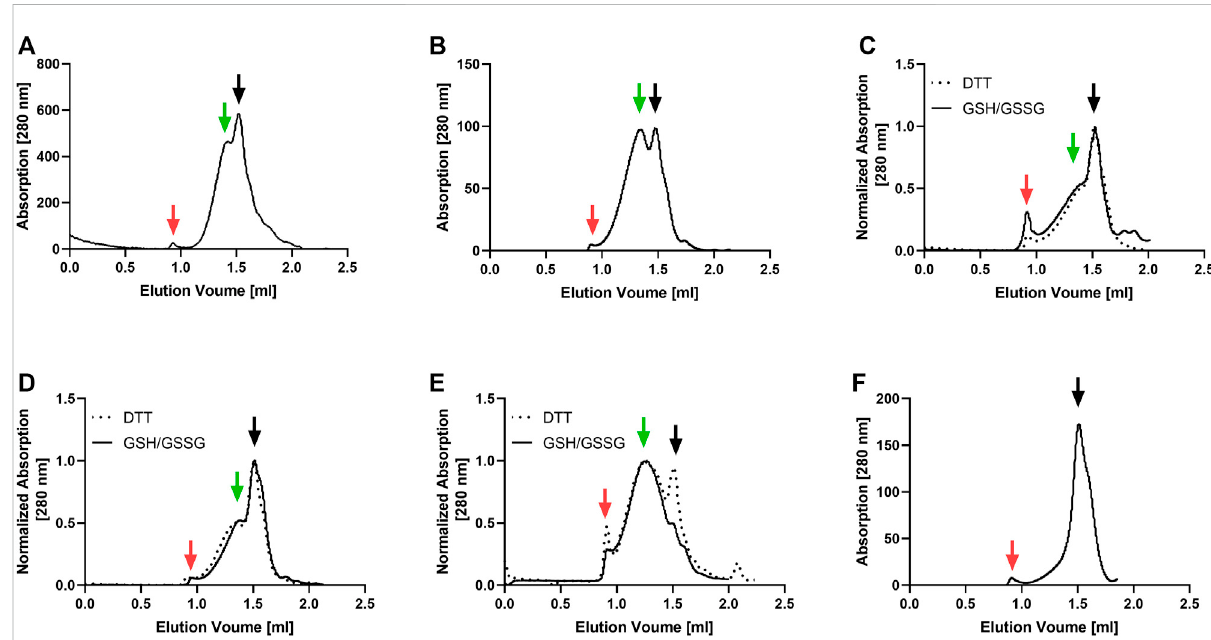
SECpro fi lingofMP/NDsamplesusedfornanotransferintomammaliancells.ThereceptorswerecotranslationallyinsertedintopreformedNDs, Strep-puri fi ed and analyzed with a Superose 6 increase 3.2/300 column. Solid and dotted lines correspond to elution pro fi les of GPCR/ND samples CF synthesized in presence of either a GSH/GSSG or a DTT redox system. (A) ETB (B) ETB-tc; (C) FFAR2; (D) GPRC5B; (E) IP; (F) PR. Void peak (red), fraction 2 (black) and fraction 1 (green) are indicated with arrows.